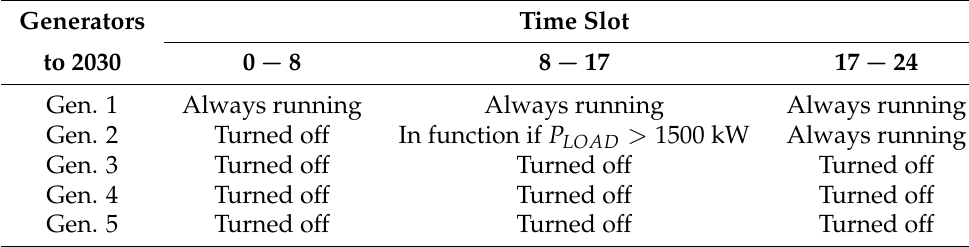
Table 19. Possible control logic of diesel groups by 2030: rest of the year. Generators